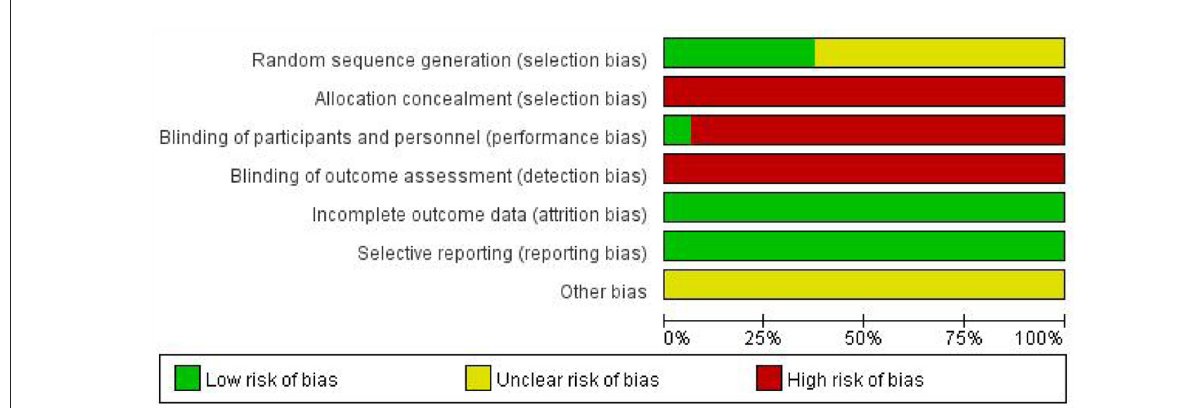
FIGURE2 Risk of bias graph.